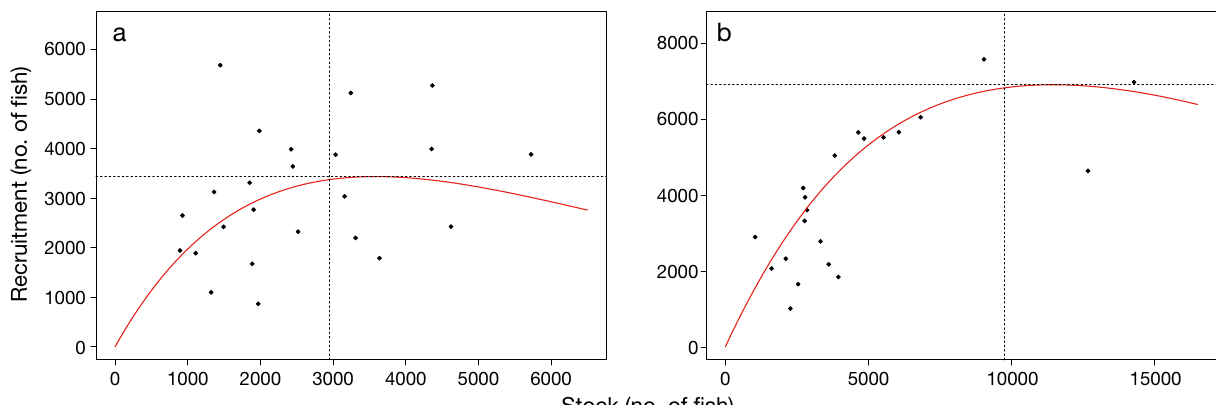
Fig. 6. Ricker stock recruitment curves fit to adult-to-adult stock-recruitment data for 1 sea-winter (1SW) Erriff River Atlantic salmon returns to (a) the river ( S iRiver ) and (b) the Irish coast ( S iCoast ). Stock values are observed returns; recruitment values are ‘corrected’ according to the annual lice effect estimated from statistical models. A 4 yr generation time (adult return to adult return) is assumed. The horizontal dashed lines are peak recruitment ( Rp ) and the vertical lines are peak stock ( Sp )